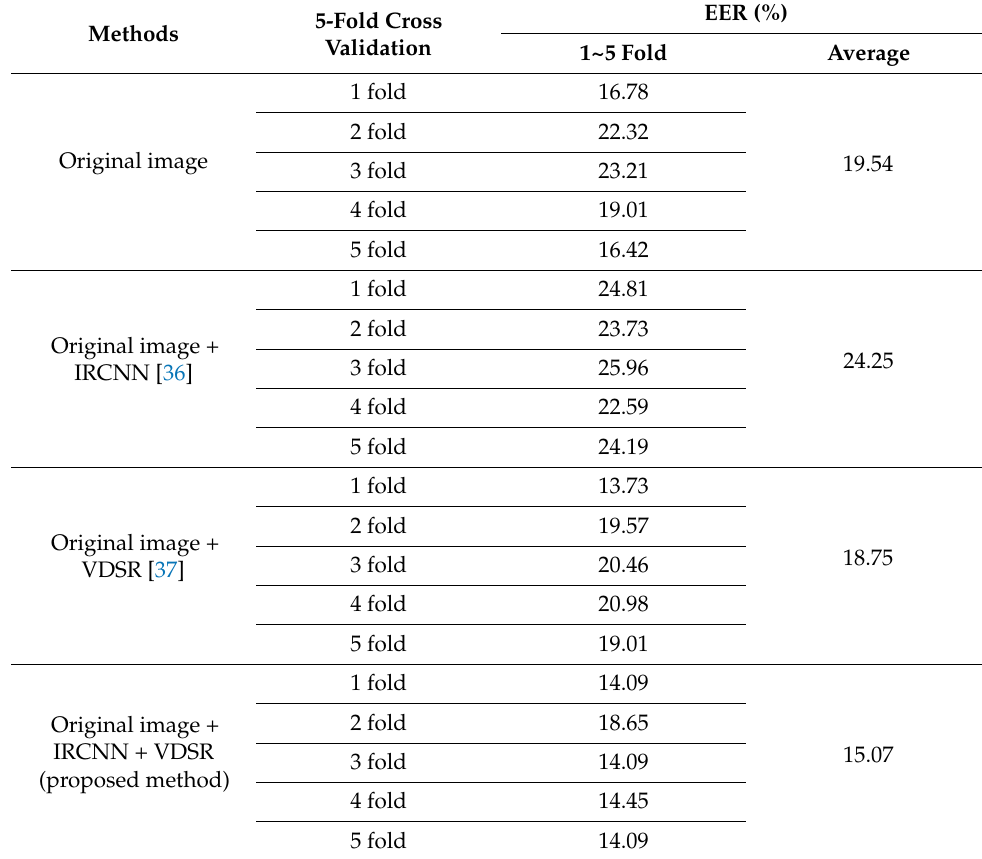
Table 8. Comparisons of gender recognition accuracies using reconstructed visible-light images.